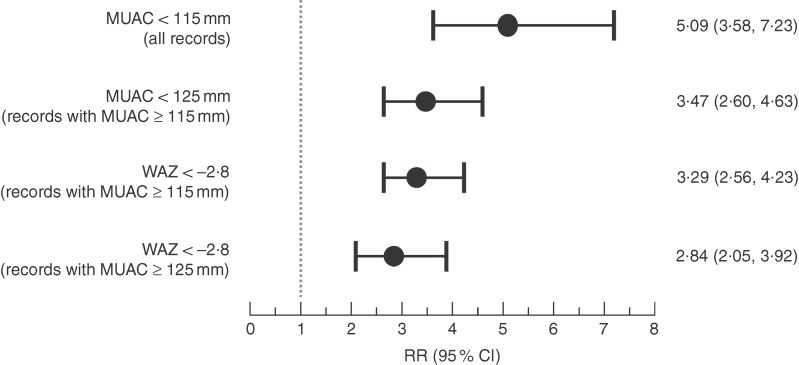
Risk ratios (RR) for death within 6 months of measurement (with their 95 % CI represented by horizontal bars) associated with different MUAC and/or WAZ case definitions among children aged 6–59 months in the Niakhar cohort data, rural Senegal(

22

) (MUAC, mid-upper arm circumference; WAZ, weight-for-age Z-score